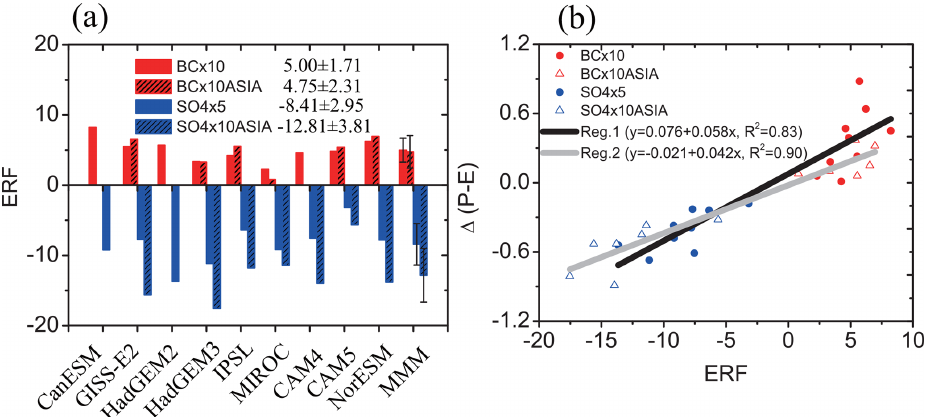
Figure 13. (a) MJJAS domain-averaged effective radiative forcing over the Asian region with 10–42.5 ◦ N and 60–125 ◦ E (ERF; unit: Wm − 2 ) under increasing global (BC × 10 and SO 4 × 5) and Asian aerosols (BC × 10ASIA and SO 4 × 10ASIA), where error bars of multimodel mean (MMM) represent the standard deviation. (b) Regression of the domain-averaged change in MJJAS precipitation minus evaporation over the Asian monsoon region ( (cid:49) ( P − E ); unit: mmd − 1 ) versus the regional ERF for global aerosols (Reg.1) and for Asian aerosols